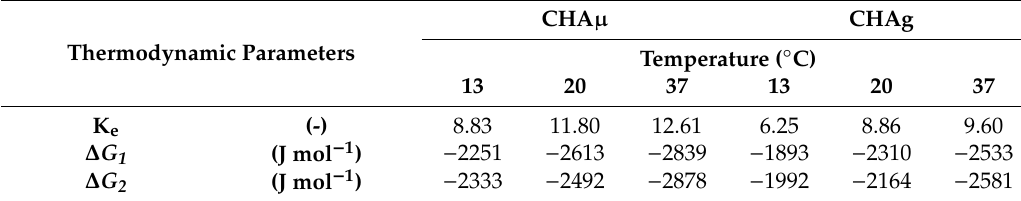
Table 4. Thermodynamic parameters of K e (Equation (16)) and ∆ G calculated by Equation (18) ( ∆ G 1 ) and Equation (19) ( ∆ G 2 ) for CHA µ and CHAg, at the temperatures of 286, 293, and 310 K (13, 20 and 37 ◦ C, respectively); see paragraph 2.6 for